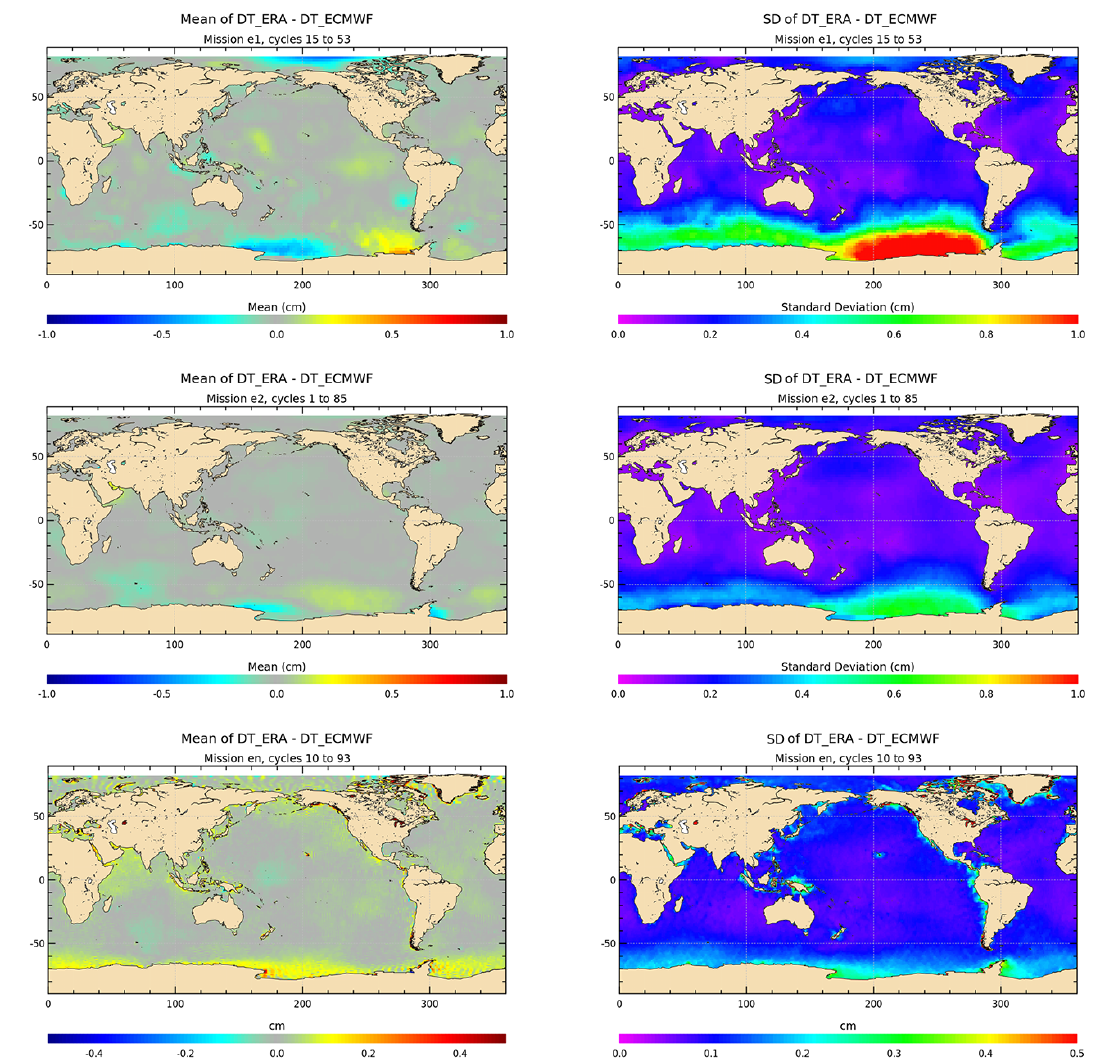
Figure 6. Maps of differences between DT_ERA and the ECMWF operational DT seen by altimeter missions ERS-1, ERS-2, and Envisat (mean and standard deviation in centimeters).